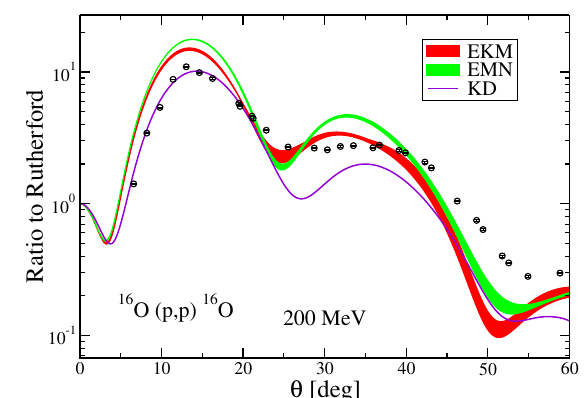
Figure (1) Ratio of the di ff erential cross section to the Rutherford cross section as a function of the center-of- mass scattering angle θ for elastic proton scattering o ff 16 O. Calculations are performed at E = 200 MeV (labo- ratory energy) with the microscopic OPs derived from the EKM [8, 9](EKM, red band) and EMN [10, 11] (EMN, green band) NN chiral potentials at N 4 LO and with the phenomenological global OP of Ref. [12] (KD, violet line). The interpretation of the bands is explained in the text. Experimental data from Refs. [13,